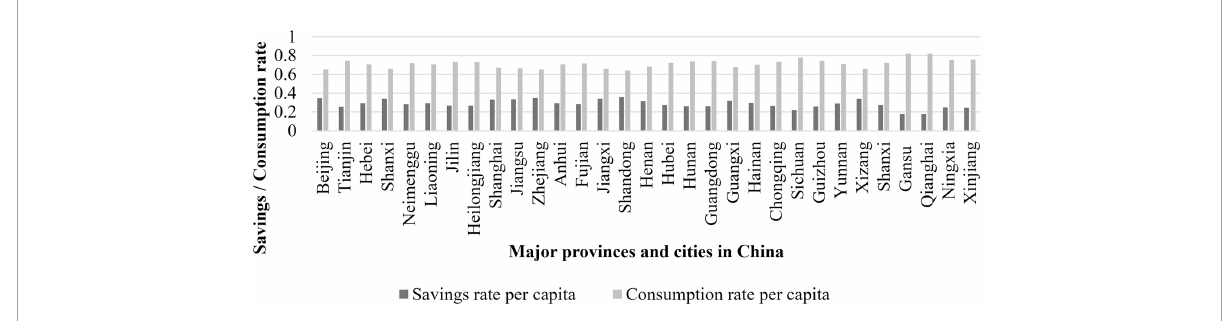
FIGURE1 Average per capita savings rate and average per capita consumption rate of residents in major regions of China (2013–2020).